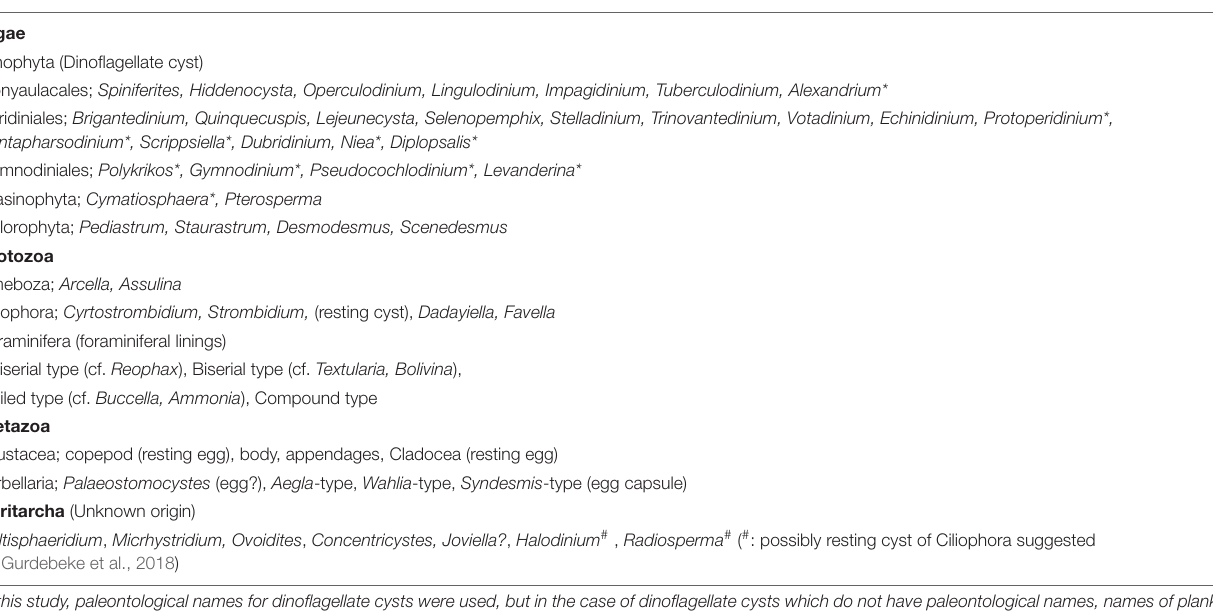
FIGURE 2 | Stratigraphic distribution of all aquatic palynomorphs observed in the core samples of Beppu Bay and Unit division based on stratigraphic cluster analysis using Bray-Curtis method. TABLE 2 | List of aquatic palynomorphs observed in sediments of Beppu